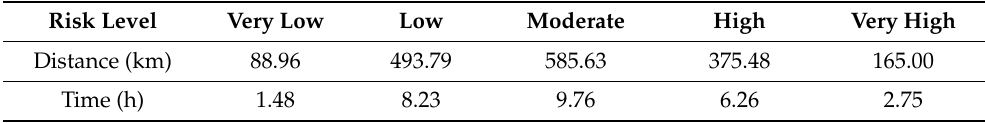
Table 2. Flight distance and time of single UAV .